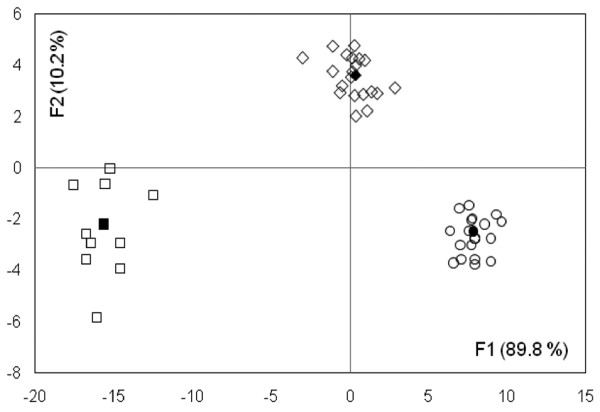
TTGE profiles FDA model. Factorial discriminant analysis (FDA) plot for TTGE profiles from CD patients studied, during both active (○) and inactive (◊) celiac disease, and controls (□). The percentages of variation described by the factorial axes (F1,F2) are shown in the parentheses. Center of gravity for each group is reported as filled symbol. Mahalanobis distances (D2), between the three centers of gravity were: active vs inactive = 93.030; active vs control = 551.840; inactive vs control = 290.021. Comparison of the aforementioned distances was statistically significant (Mann-Whitney and Wilcoxon tests, P < 0.0001) between the three groups of patients. The predictability of the model is 100%.